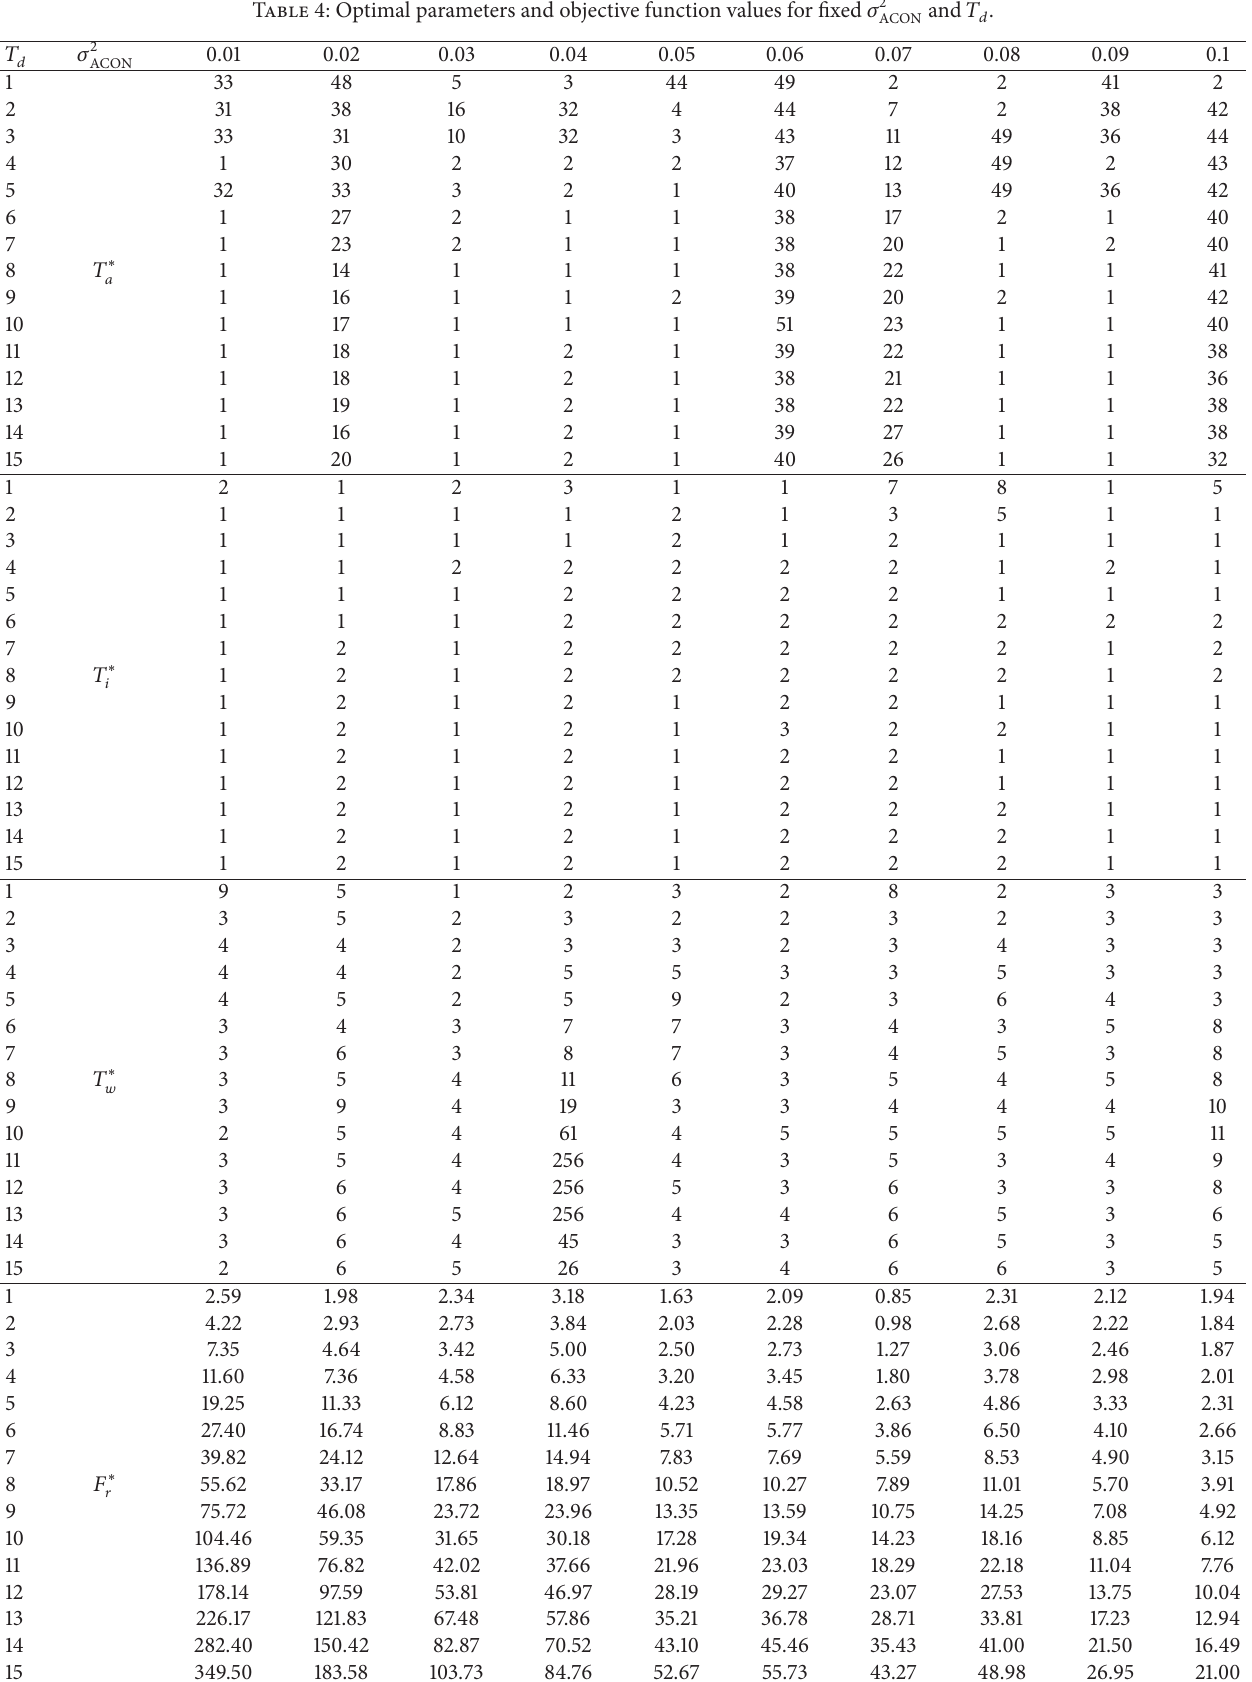
Table 4: Optimal parameters and objective function values for fixed 𝜎 2 ACON and 𝑇 𝑑